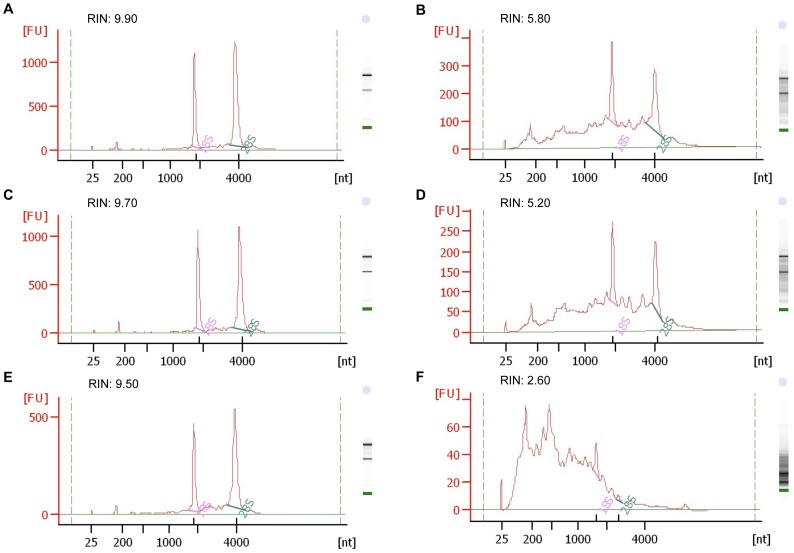
Analysis of RNA integrity in unfixed and fixed cells.RNA integrity analysis of RNA isolated from unfixed and fixed samples was performed using Agilent 2100 Bioanalyzer. Representative electropherograms for unfixed (A, C, E) and fixed (B, D, F) samples of each cell type, K562 (A, B), CEMx174 (C, D), human PBMCs (E, F), are shown. The RNA Integrity Number (RIN) is shown for each sample.